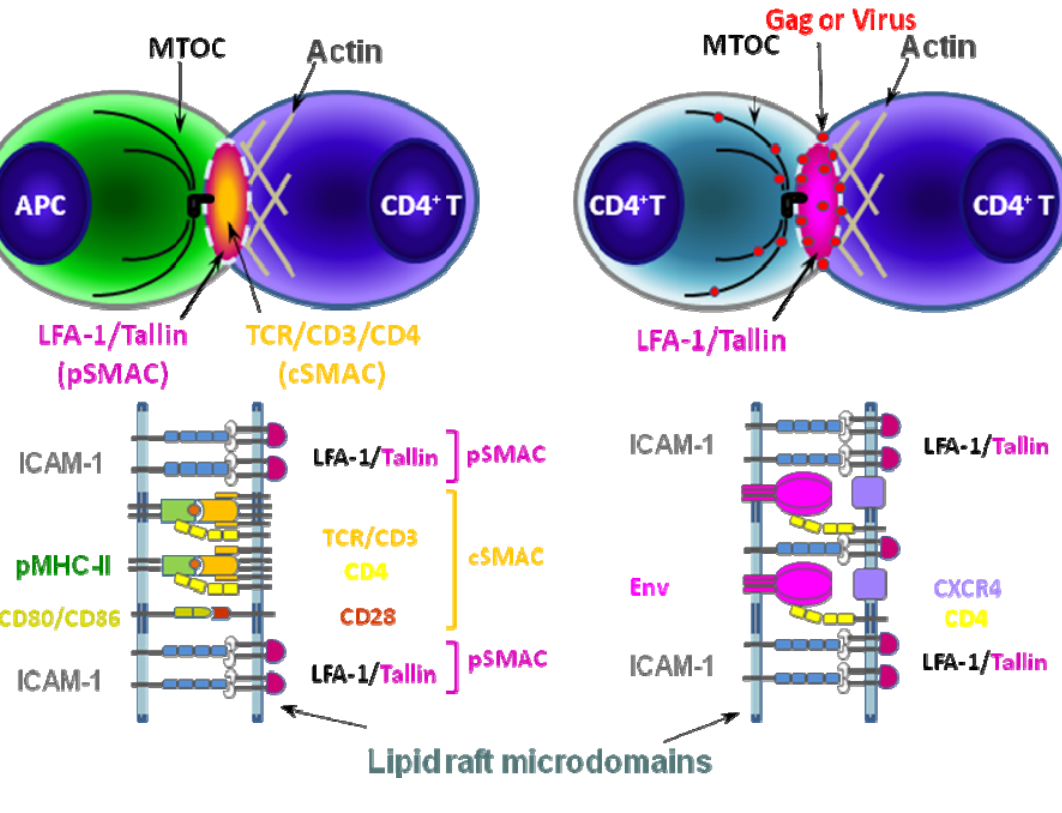
Figure 2. Schematic models of immunological synapse (IS) between APC and CD4 + T cell (left) and virological synapse (VS) between CD4 + T cells (right). The formation of an IS MHC-II (pMHC-II) on the APC by its cognate TCR/CD3/CD4 receptors on the CD4 + T cell. The adhesion molecules (ICAM-1 and LFA-1) and co-stimulatory